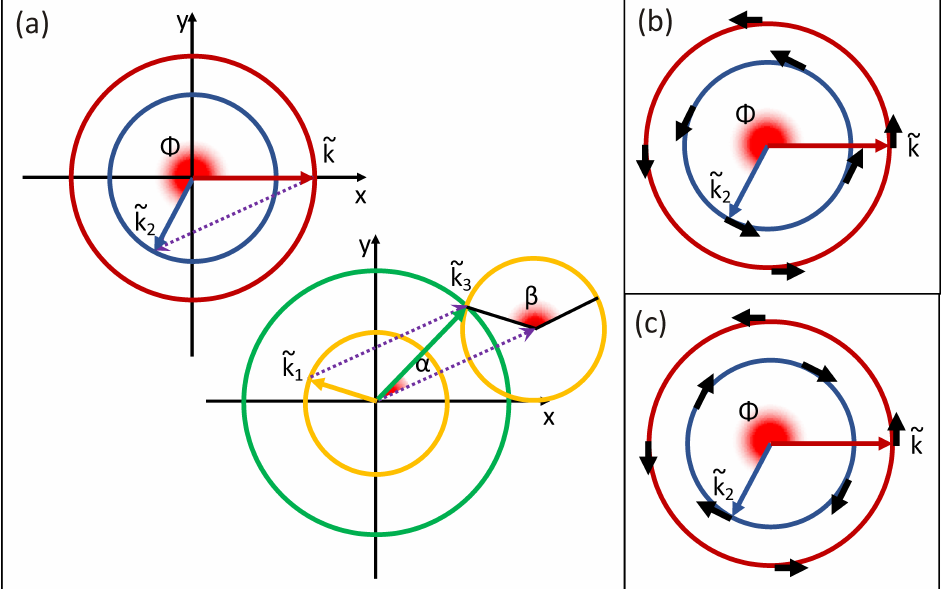
Figure 1. ( a ) geometrical representation of the momentum conservation for electron–electron scattering; ( b , c ) mutual orientation of the spin in initial and final states in case the two states have the same or opposite handedness,